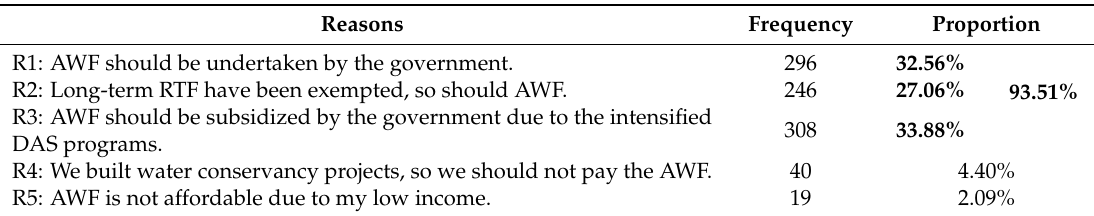
Table 3. Reasons farmers thought they should not pay the